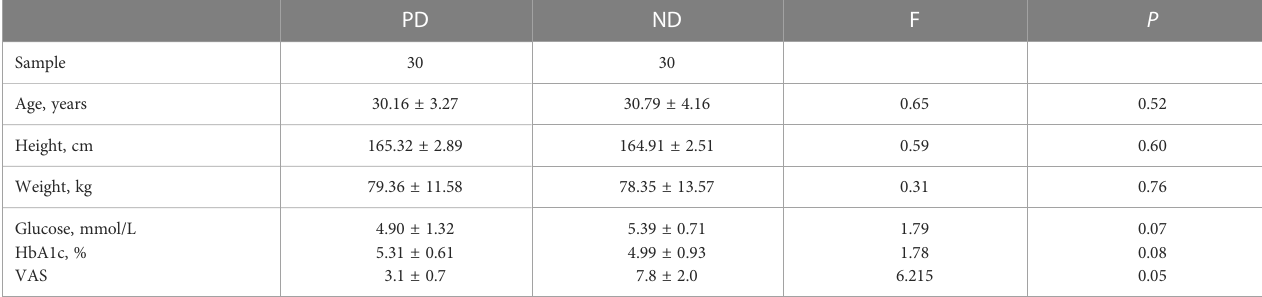
TABLE 1 Demographic